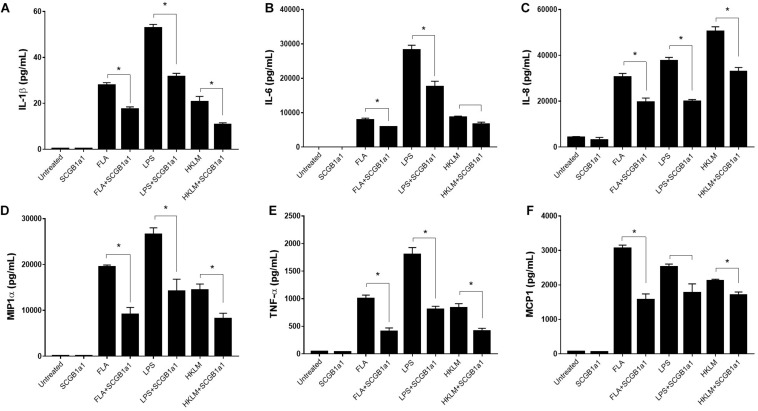
SCGB1A1 attenuates AM-mediated inflammation. Cytokine and chemokine release from purified C57BL/6 AMs in response to toll-like receptor (TLR) agonists were measured: TLR2- heat-killed Listeria monocytogenes (HKLM), TLR4-Lipopolysaccharide from Escherichia coli K12 (LPS), and TLR5- Salmonella typhimurium Flagellin (FLA) in the presence or absence of recombinant SCGB1a1 protein. The panels depict IL-1b (A), IL-6 (B), IL-8 (C), MIP1a (D), TNF-α (E), and MCP1 (F) responses to TLR stimuli. Data from three biological replicates are plotted as mean ± SEM, two-tailed unpaired t-tests were applied, and p < 0.05 was considered significant (*).